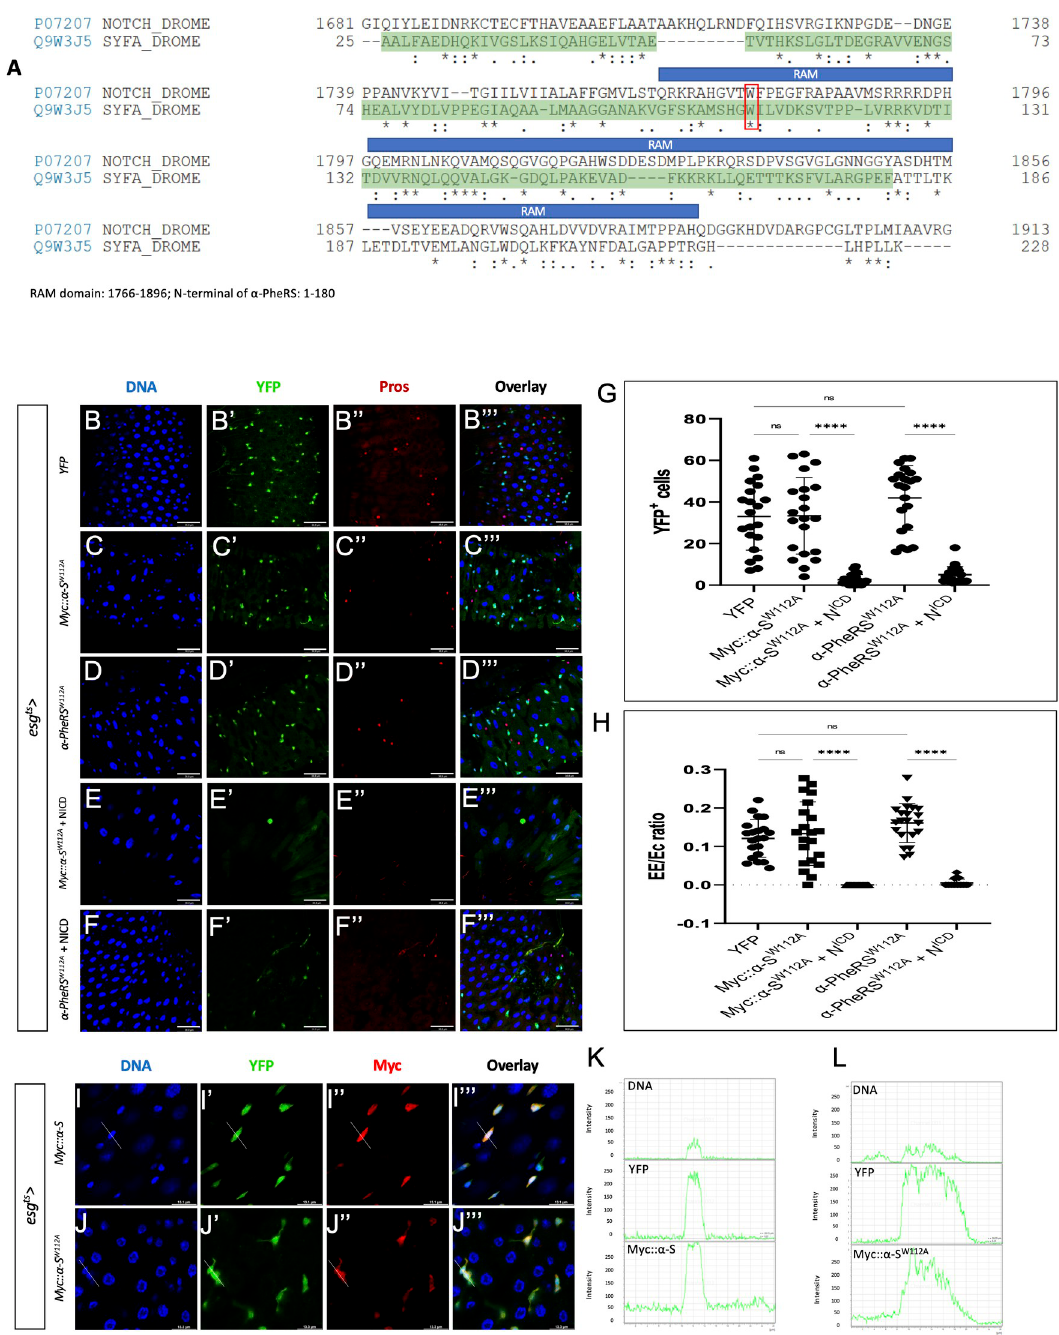
Fig 7. Possible mechanism of the competition between N ICD and the α -S activity. (A) The alignment of Notch and α -PheRS shows that moderately conserved motives are present in the RAM domain (1766–1896 aa) and the N-terminal sequence of α -PheRS (1–180 aa). The DNA binding domain (DBD) is shown shaded in green. The alignment task was conducted by the Alignment Tool of the Uniprot website (https://www.uniprot.org/) with two FASTA polypeptide sequences of Drosophila Notch and Drosophila α - PheRS. � (asterisk) indicates positions that have a single, fully conserved residue. “:” (colon) indicates conservation between groups of strongly similar properties—scoring > 0.5 in the Gonnet PAM 250 matrix. A “.” (period) indicates conservation between groups of weakly similar properties—scoring = < 0.5 in the Gonnet PAM 250 matrix. (B-D”’) Elevated YFP (control), Myc:: α -S W112A or α - PheRS W112A levels induced by the esg ts system (see Fig 1E for details) did not lead to additional YFP-positive cells and also not to the hyper-accumulation of EEs. (E- F”’) Neither elevated Myc:: α -S W112A nor α -PheRS W112A levels rescued the depleted ISC pool caused by Notch over-activation (induced by expressing the NICD under the same control). Note that F shows only 2 Pros + cells, the